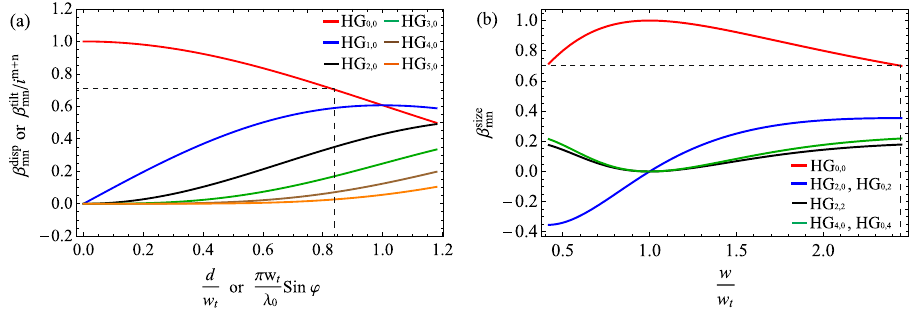
disp tilt mn ) and tilt ( β mn ) in ( a ) and size π w t sin ϕ/ (cid:31) 0 0.83 and w / w t 2.45 = = =